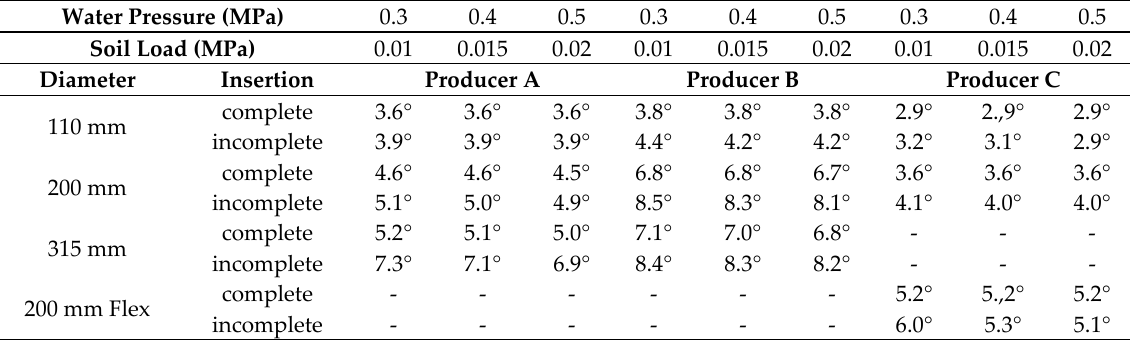
Table 2. Overview of the maximum acceptable angular deflections found for all simulated systems and loading